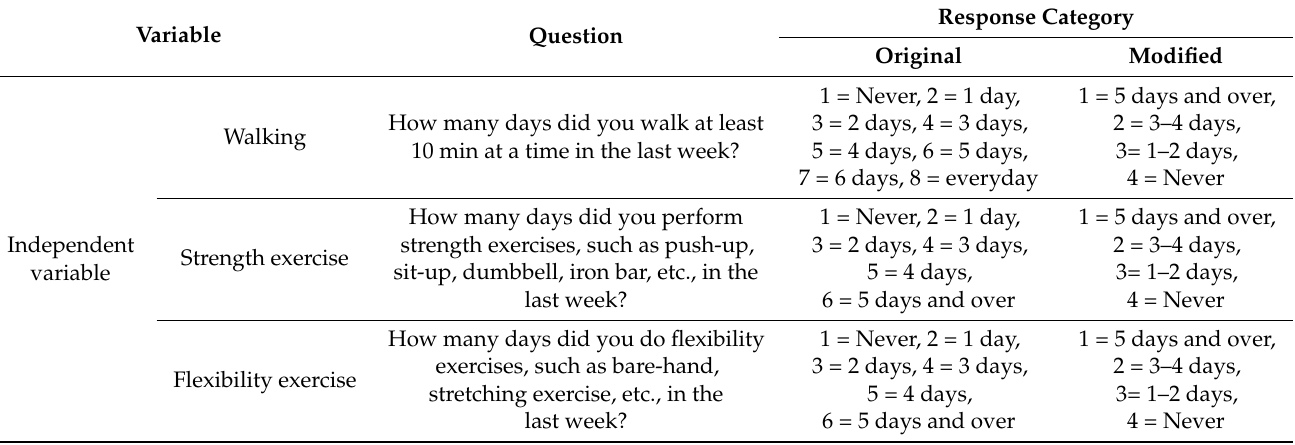
Table 2. The variables of the